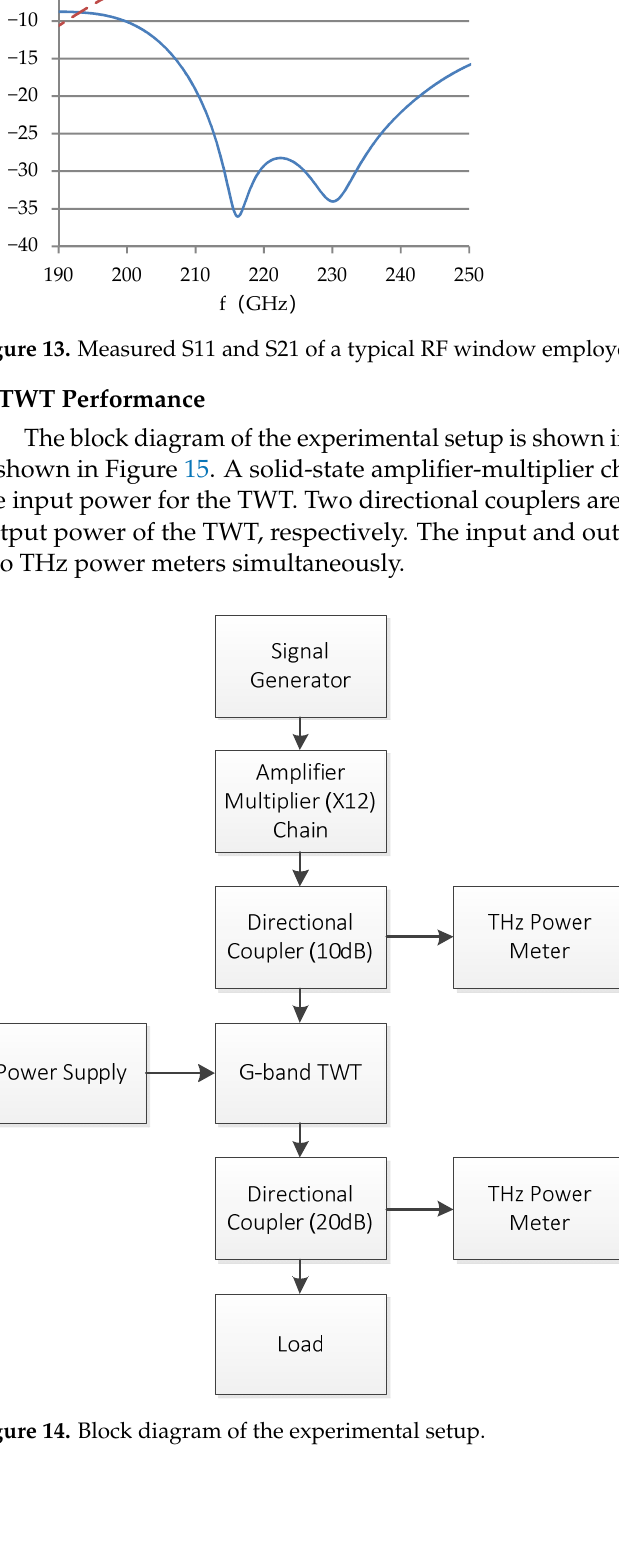
Figure 14. Block diagram of the experimental setup.